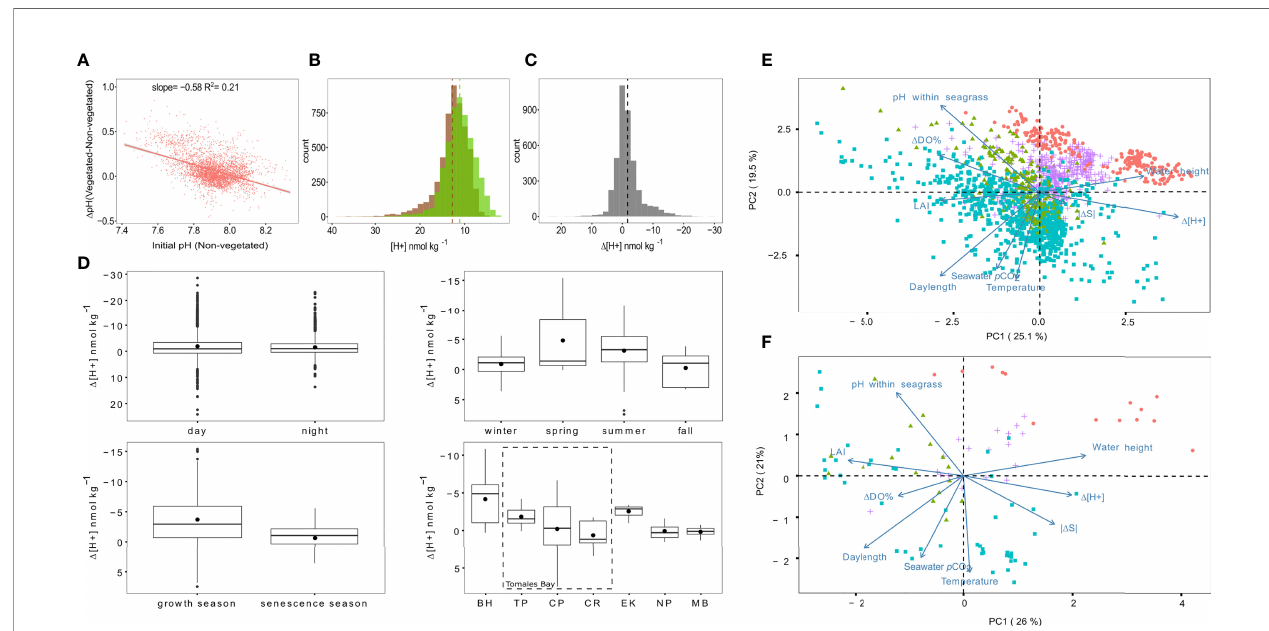
FIGURE 1 | Corrections and clari fi cations to fi gures and assertions of VD. (A) Corrected version of VD ’ s panel A, showing D pH as a function of outside-meadow pH. Since D pH re fl ects a relative change in hydrogen ion concentration ([H + ]) with respect to baseline conditions outside a seagrass meadow, it is more appropriate to use outside-meadow pH as the independent variable, rather than inside-meadow pH as was done in VD. The correction shown here results in a reversal of the slope of VD ’ s teal point cluster. The red point cluster in VD ’ s panel A depicts the same data as the teal points, except with outside-meadow pH on the x-axis. However, the red cluster is incorrect because it plots an inversion of D pH (i.e., - D pH) as the dependent variable rather than D pH; this mistake arti fi cially in fl ates the number of negative D pH data at low pH in VD ’ s graph. Thus, the red points are simultaneously unnecessary and misleading. (B, C) Replotted versions of Figures 1A, 1B from Ricart et al. (2021), using [H + ] instead of pH. Patterns here show matching trends to the fi gures of the original article, despite the change from logarithmic to arithmetic scaling along the x-axis. Colors indicate data from seagrass ecosystems (green), adjacent non-vegetated areas (brown), and differences between seagrass ecosystems and non-vegetated areas (grey). Dashed lines denote mean values. (D) Replotted version of Figure 5 from Ricart et al. (2021), demonstrating that key results again remain invariant if D [H + ] is used instead of D pH. Note that y-axis values here run from positive at the bottom to negative at the top (expected given pH=-log[H + ]), with negative D [H + ] corresponding to amelioration of low pH. Top left, D [H + ] during daytime compared to nighttime; top right, comparison of D [H + ] among seasons; bottom left, comparison of D [H + ] between seagrass productivity periods; bottom right, comparison of D [H + ] among sites ordered latitudinally from north at left to south at right, including three seagrass meadows within Tomales Bay (dashed box). See Ricart et al. (2021) for additional details. (E, F) Principal components analyses (PCA) analogous to that of Figure 6 in Ricart et al. (2021) using D [H + ] instead of D pH and incorporating D DO% and | D S| measurements. Results are shown for both the 1-h and 24-h datasets, respectively. Note that in both plots, D [H + ] is negatively correlated with D DO% and positively correlated with | D S|, indicating that amelioration events [negative D (H + ) values] tend to comport mainly with photosynthesis as a driver, and not with conditions characterized by strong water property gradients. RMS velocity does not appear in these plots, due to greater numbers of gaps in the velocity and D DO% records, which reduces their temporal overlap and prevents their simultaneous